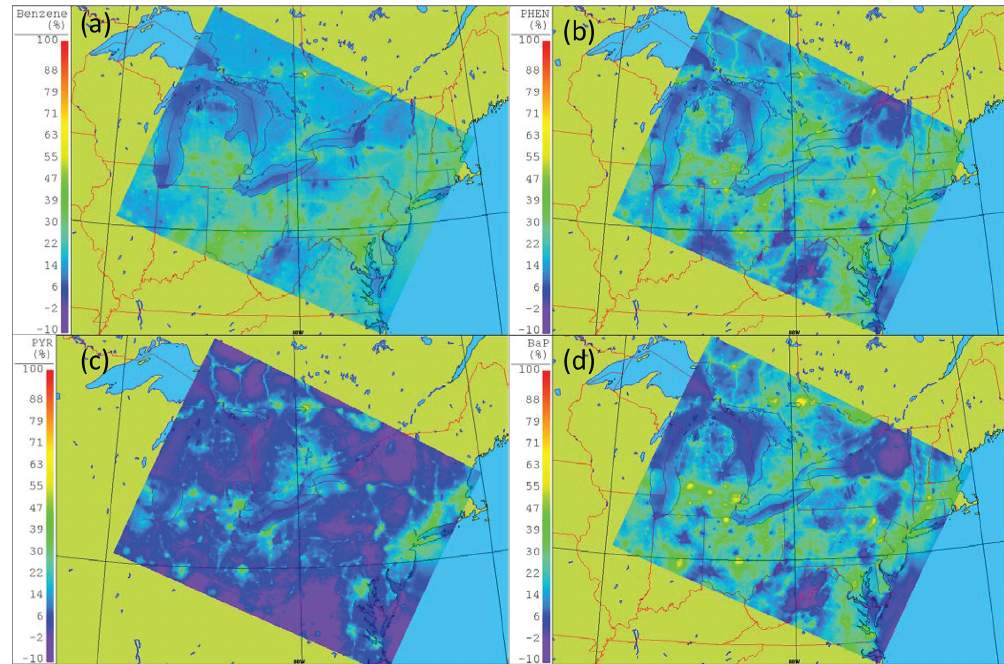
Figure 4. Seasonal-average relative on-road vehicle contributions to ambient concentrations of (a) BENZ, (b) PHEN, (c) PYR, and (d) BaP in the spring–summer.